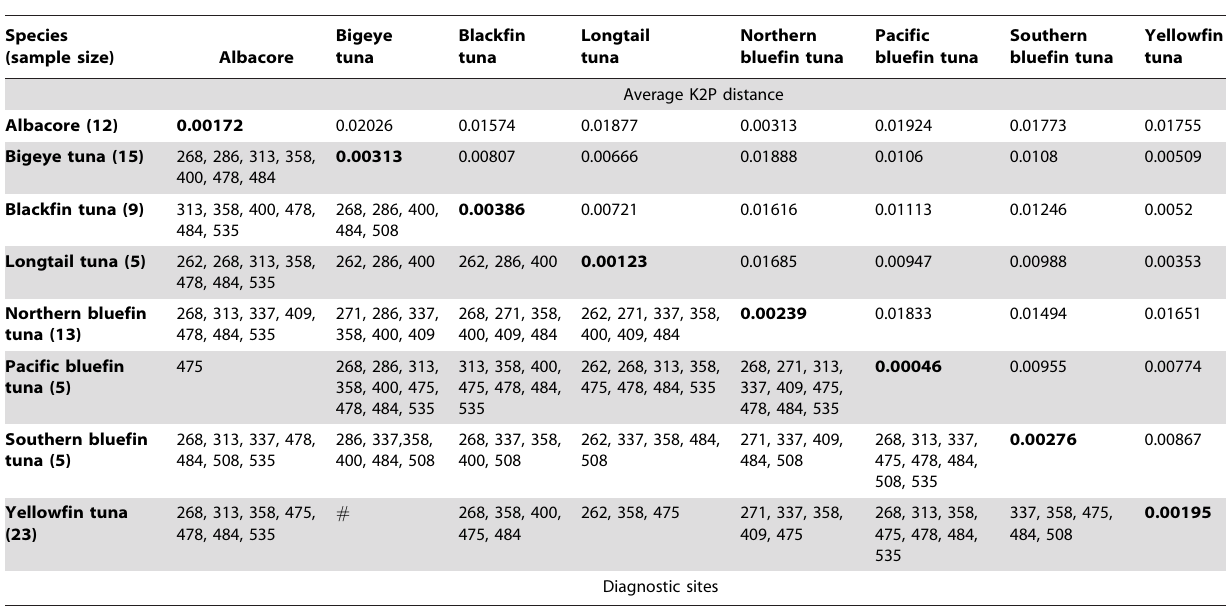
Table 2. Average K2P distance and diagnostic sites for the eight species comprising the genus Thunnus .